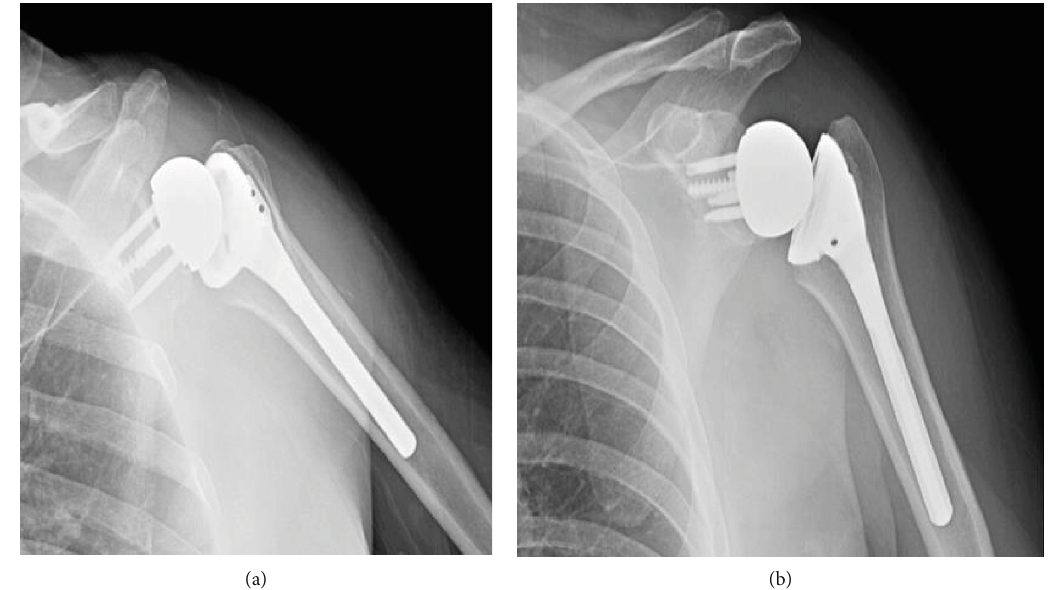
Figure 4: (a, b) Postoperative radiographs of Case 1 demonstrating reverse shoulder arthroplasty following fi xation of large glenoid rim fracture via the